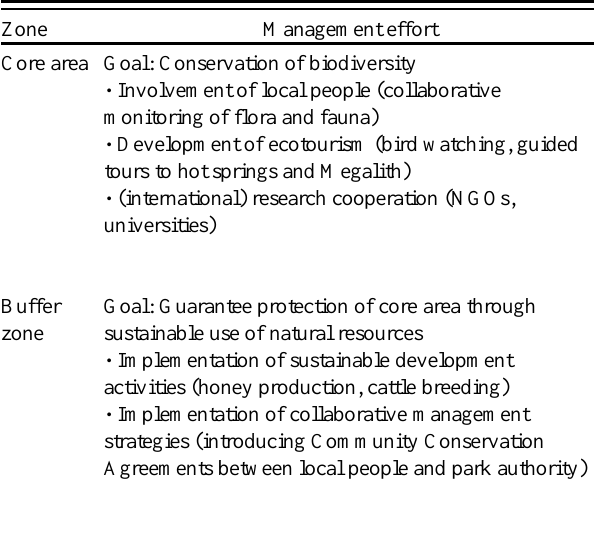
Table 1 . Management plan draft for Lore Lindu Biosphere